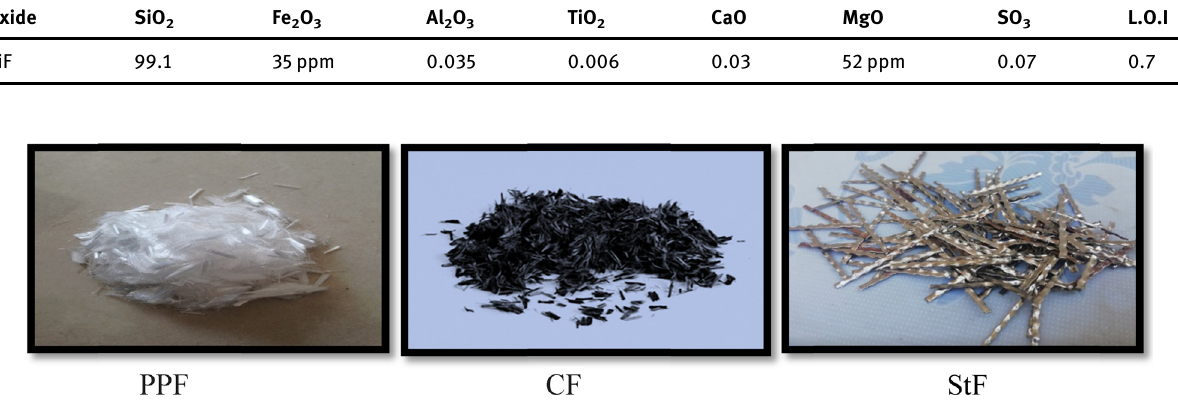
Figure 3: Fiber types used in this